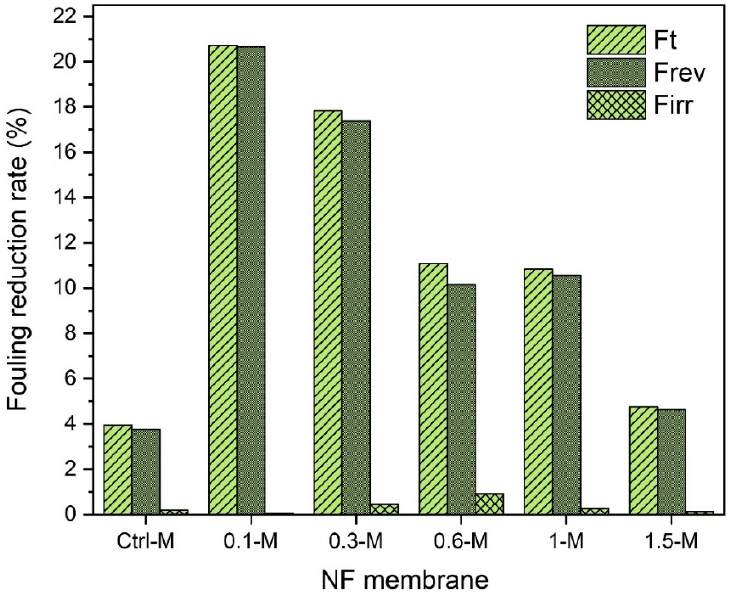
Figure 13. Fouling behavior of NF membranes with 50-ppm cadmium solution.